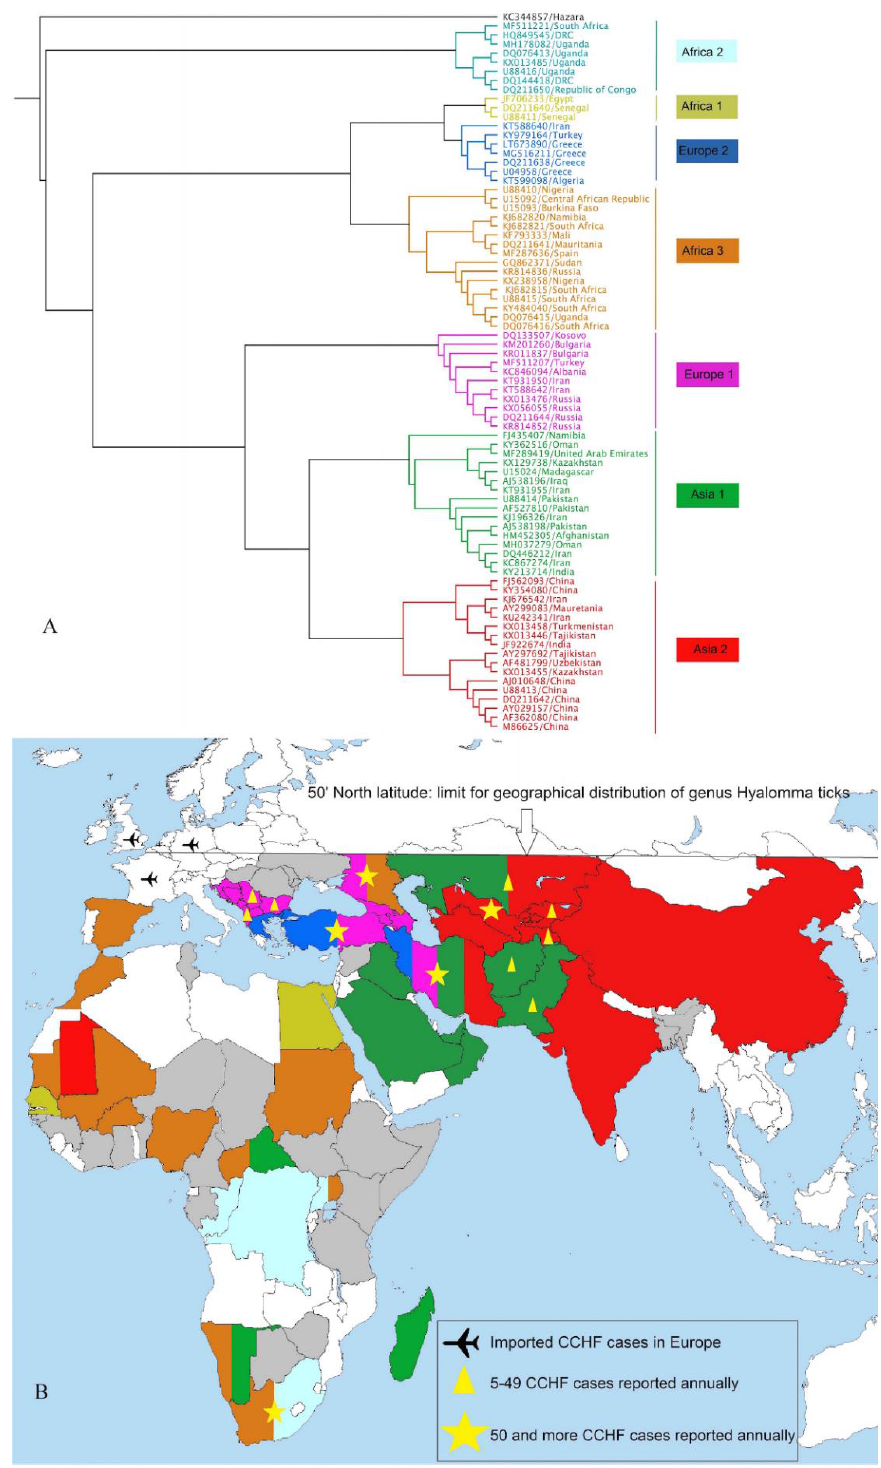
Figure 1. A Kimura 2-parameter model was selected to construct the phylogenetic Maximum Likelihood tree based on the S-segment of CCHFV using Geneious software V 11.0.5. The number of bootstraps was set at 1000 replications. The phylogenetic tree shows clustering of CCHFV strains in seven clades ( A ). Countries with one or more CCHFV strains are colored based on phylogenetic tree (Figure 1A). Countries with serological evidence for CCHFV are colored in grey. Imported CCHF cases to non-endemic countries in Europe are demonstrated ( B ).